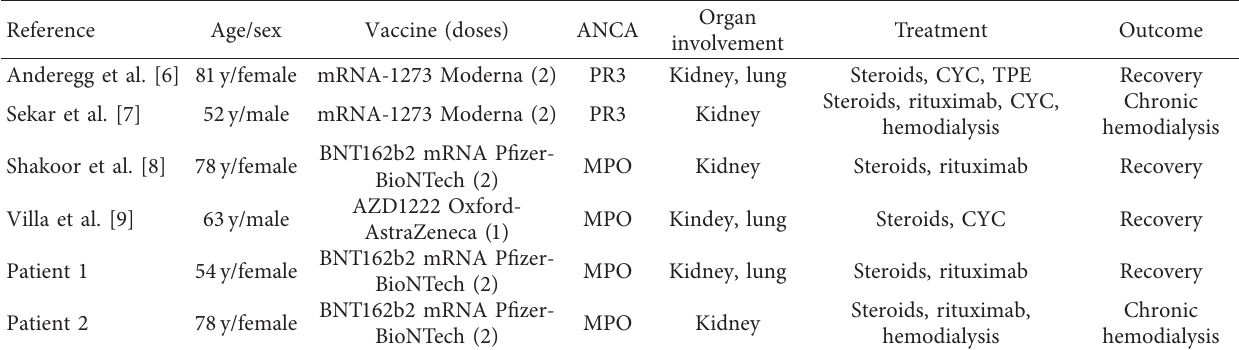
Figure 1: (a) Masson trichrome stain 400 x ; kidney core biopsy of patient 1 with glomerular capillary necrosis and acute extravasation of fibrin into Bowman’s space with a fibrocellular crescent (arrows). (b) PAS stain of a glomerulus with rupture of Bowman’s capsule and segmental tuft sclerosis. Adjacent segmental vessel wall necrosis of an interstitial arteriole (arrows) depicting highly acute microangiopathic vasculitis is shown. Table 2: Summary of reported cases of ANCA vasculitis after SARS-CoV-2 vaccination.